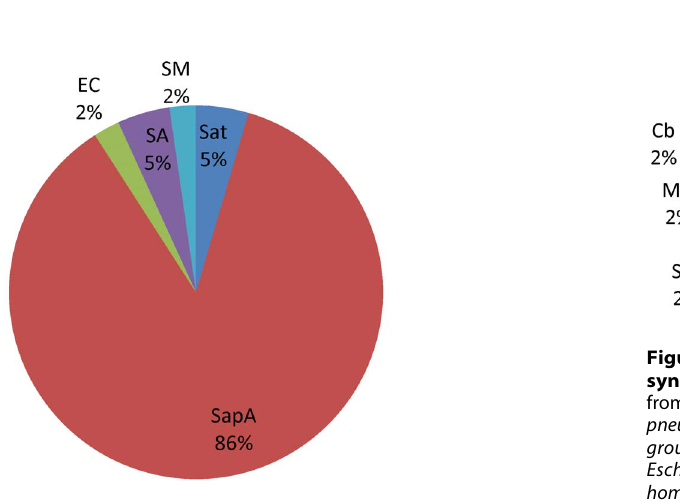
Figure 4. Etiological distribution of fever and rash syndrome in Guangxi, China, 2009–2011. Of 44 etiologies cultured from specimens of fever and rash syndromes: Salmonella paratyphi A (SapA,38 strains), Salmonella-typhi (Sat,2), Escherichia coli (EC,1), Staph- ylococcus aureus (SA,2), Stenotrophomonas maltophilia (SM,1).